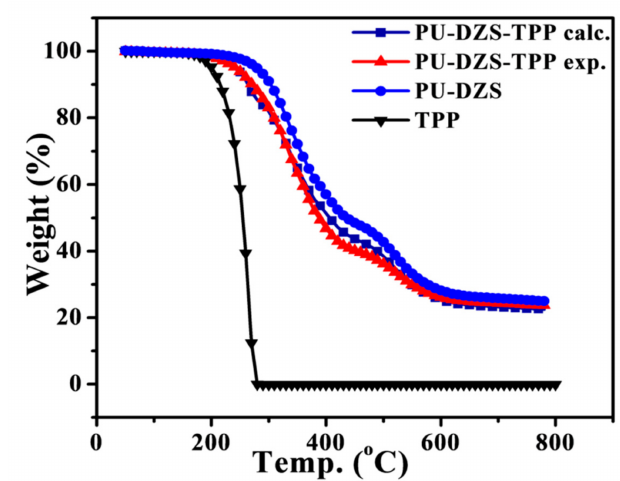
Figure 9. TGA thermograms of TPP, PU-DZS, and their mixtures (experimental and calculated) in N 2 at a rate of 10 ◦ C/min.